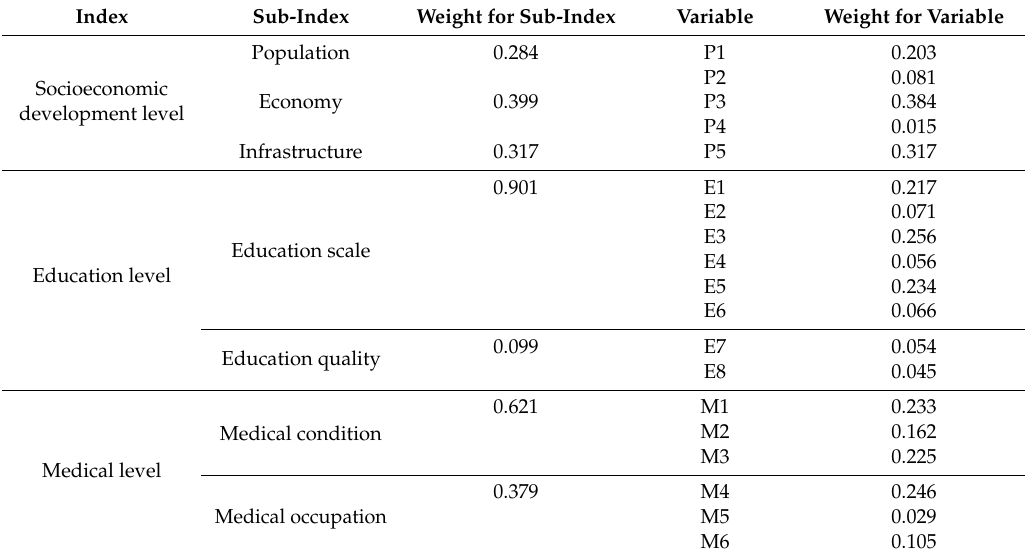
Table 4. The weights of indexes for local socioeconomic development, education and medical